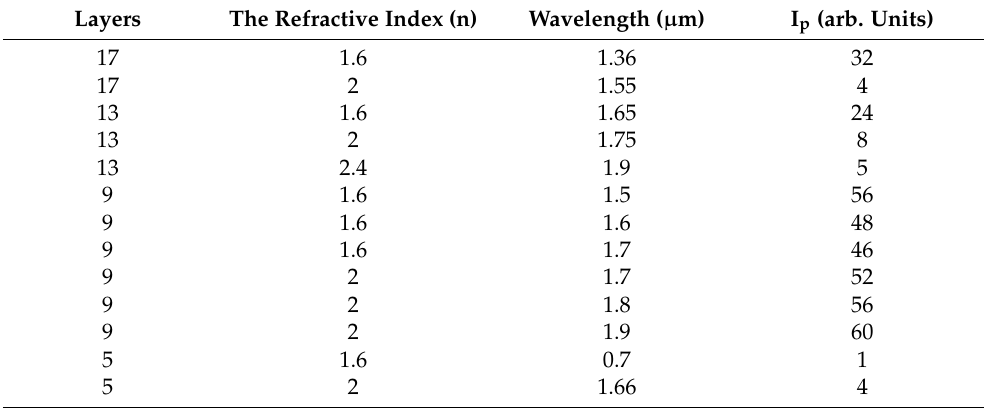
Table 1. Parameters of effective convergence points corresponding to different